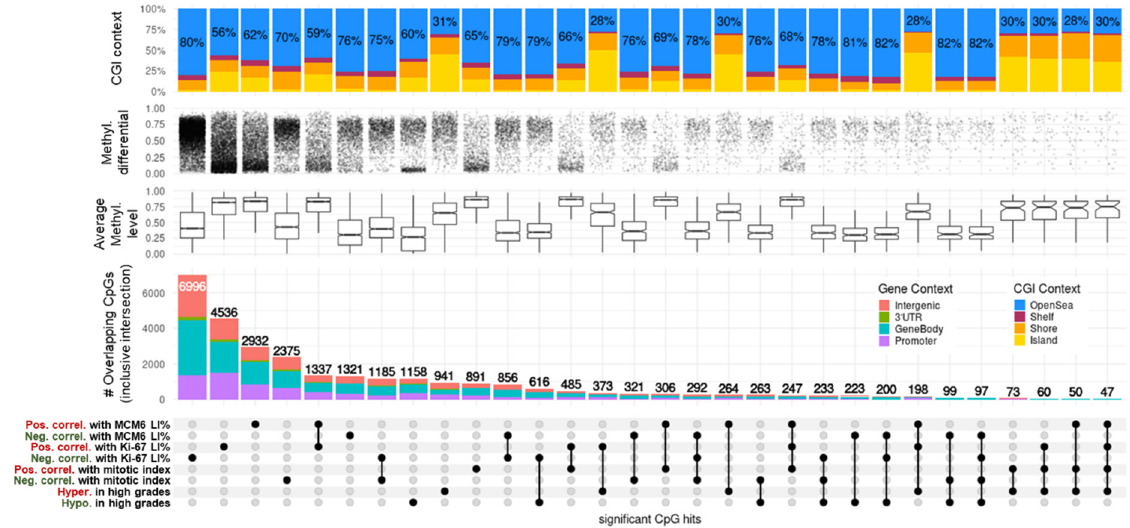
Figure 3. UpSet plot summarizing the overlap between CpGs highly correlated with proliferation indices and grades in meningiomas. Every possible intersection is displayed (30 in total, including the 8 original hit lists shown on the bottom-left side). All intersections are inclusive. CpG regulatory contexts (gene and CGI annotations) are represented as proportions of barplot heights. Proportions of open-sea CpGs are displayed on CGI context bar plots. Average methylation levels are represented as boxplots of means (beta value) for each CpG of the intersected lists. Methylation differentials represent the range of each CpG beta value (max–min) and the densities of changes. DNAm: DNA methylation; methyl: methylation; CGI: CpG island; pos. correl: positive correlation; neg. correl: negative correlation; hypo: hypomethylation; hyper: hypermethylation; LI: labeling